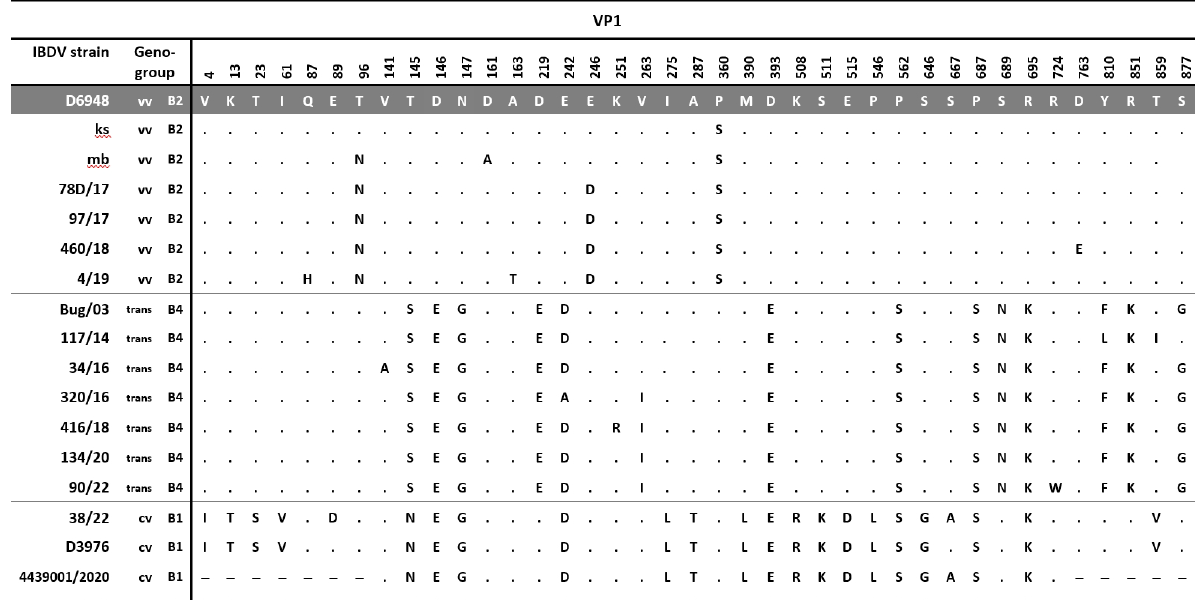
Figure 4. Comparison of amino acid substitutions in viral proteins encoded by segment A between Polish and reference strains. Dots show identity with D6948. The amino acids forming the P BC (aa